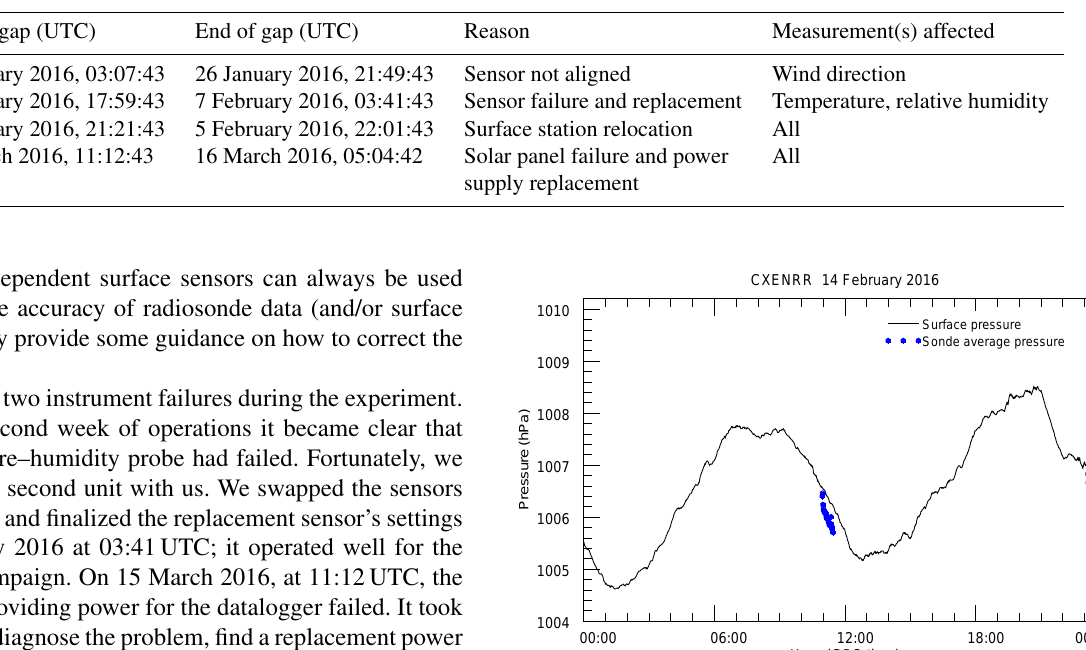
Table 3. Major gaps in the Kiritimati surface data set. Data collection started 25 January 2016, 03:07:43UTC and ended 28 March 2016,